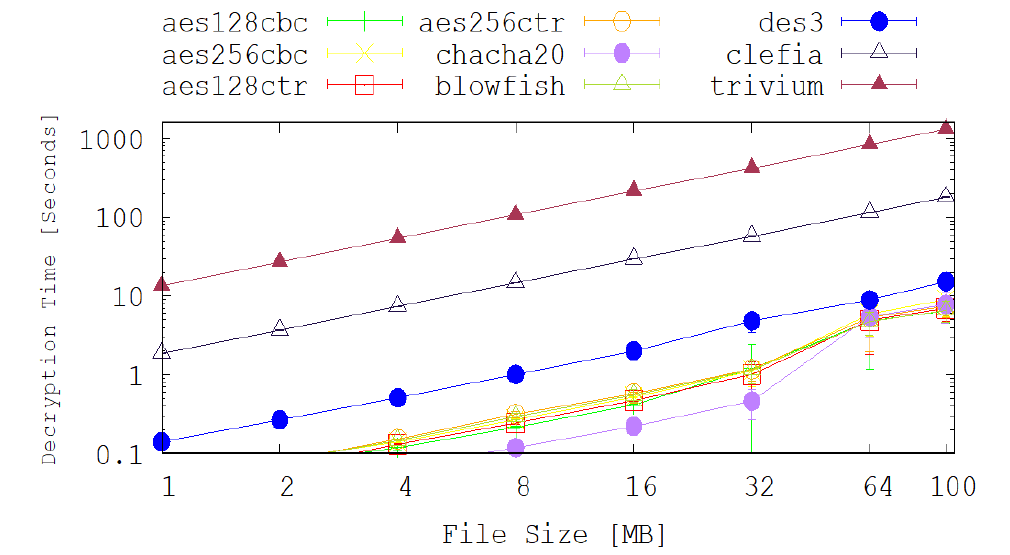
Figure 4. A comparison of the achieved decryption time (in ms) by several legacy and lightweight cryptography